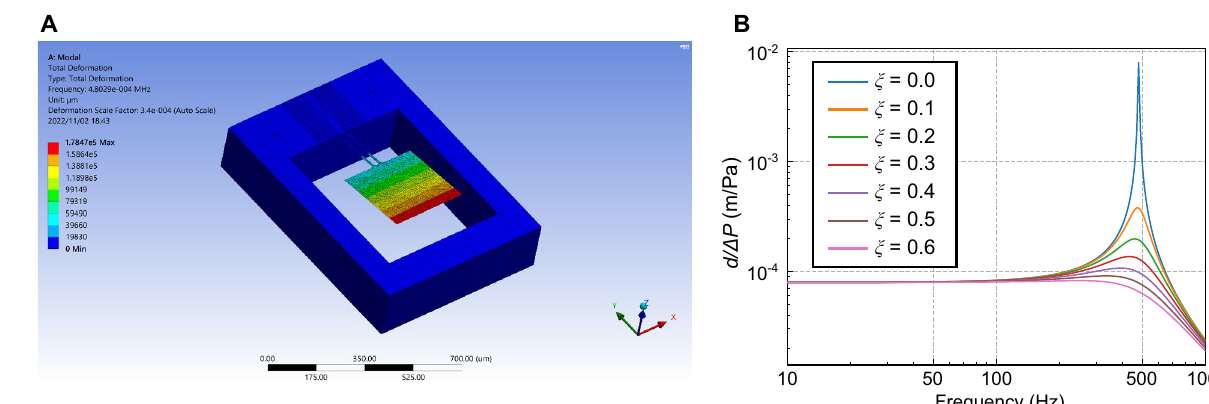
Figure 2. ( A ) FEM simulation of the proposed cantilever. ( B ) FEM simulation results sweeping the damping factor.